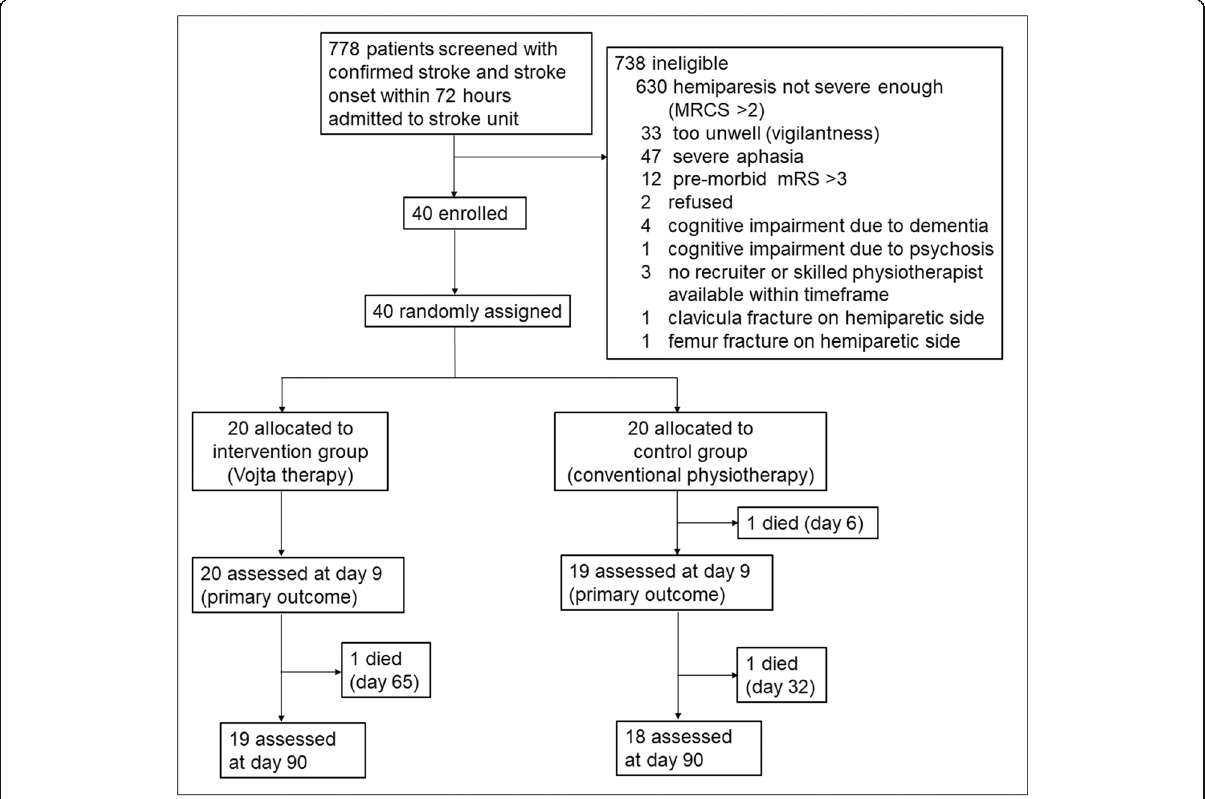
Fig. 1 Consort diagram on trial flow. MRCS = medical research council scale for muscle strength; mRS = modified Rankin